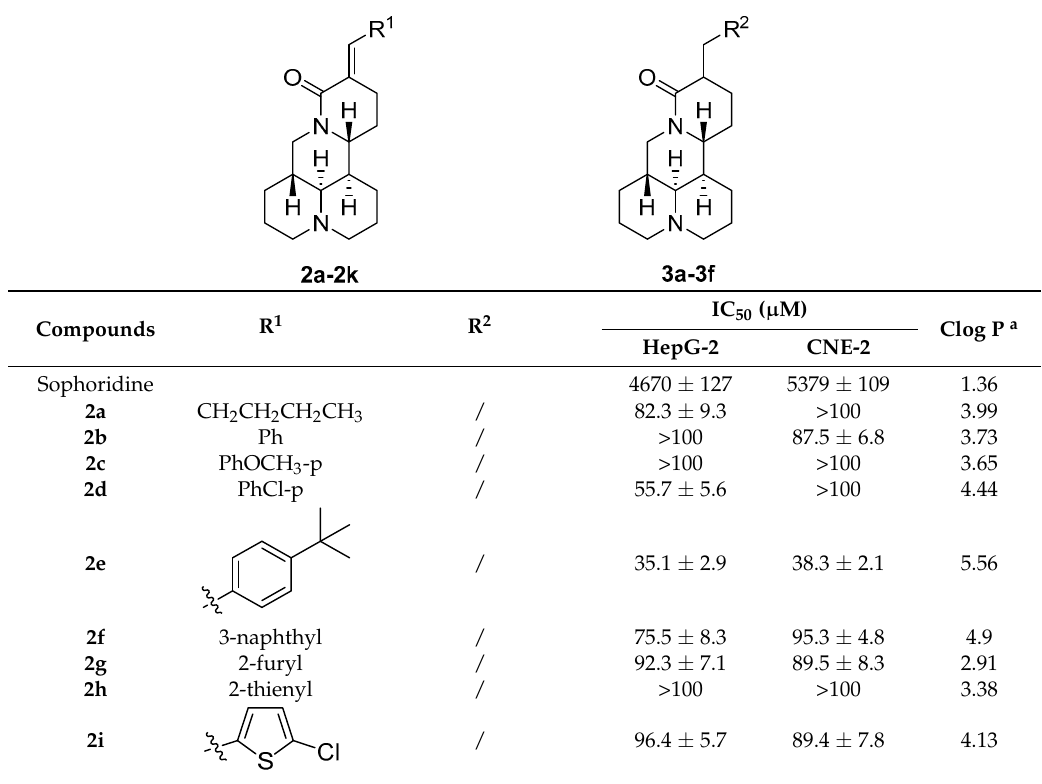
Table 1. Structure-activity relationship of the sophoridinic derivatives for their antiproliferative activities in HepG-2 (human liver cancer cell line) and CNE-2 (human nasopharyngeal carcinoma cell line) cells.